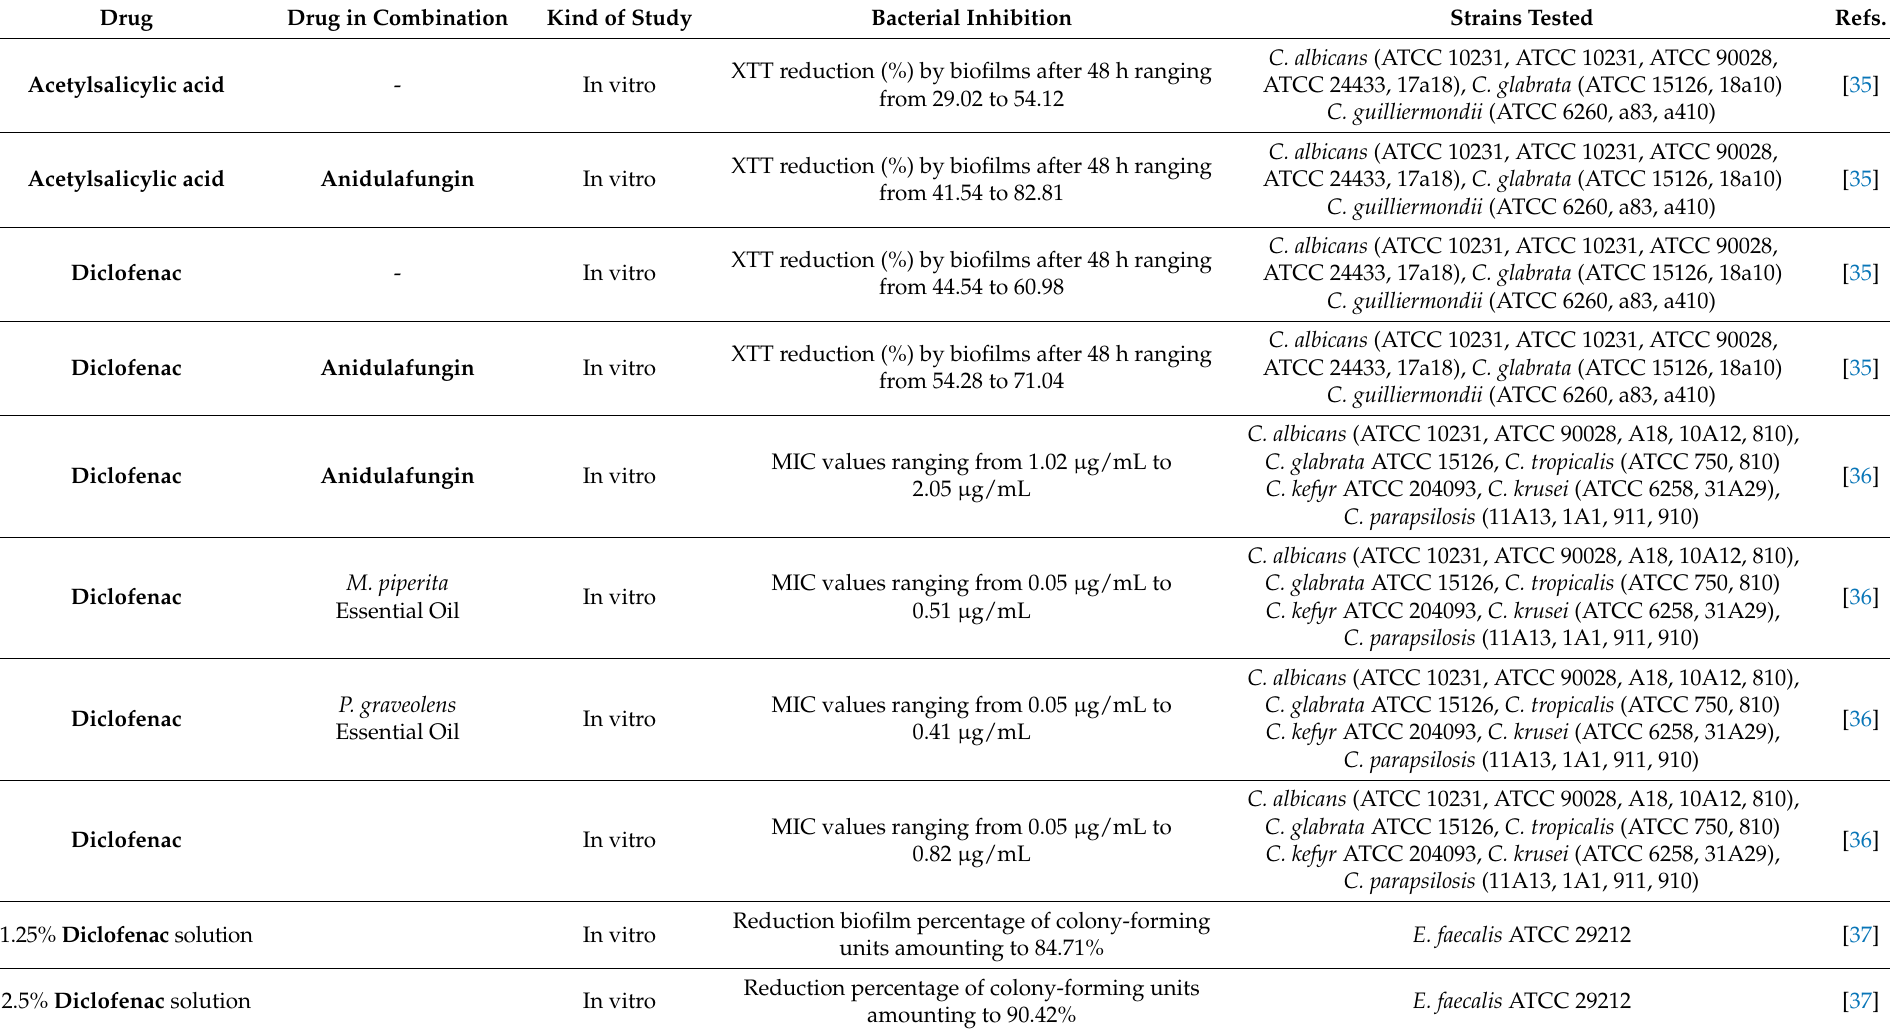
Table 1. Antimicrobial activity of